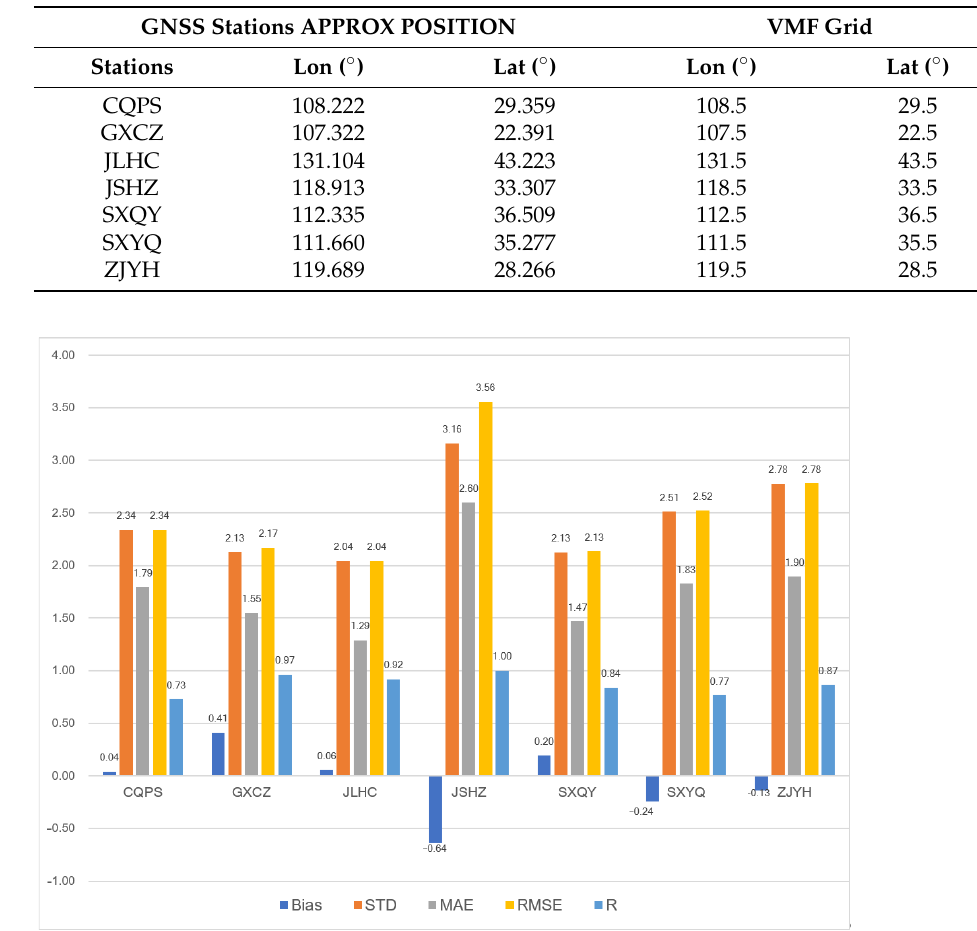
Figure 5. Testing the accuracy between GNSS ZTD and VMF ZTD